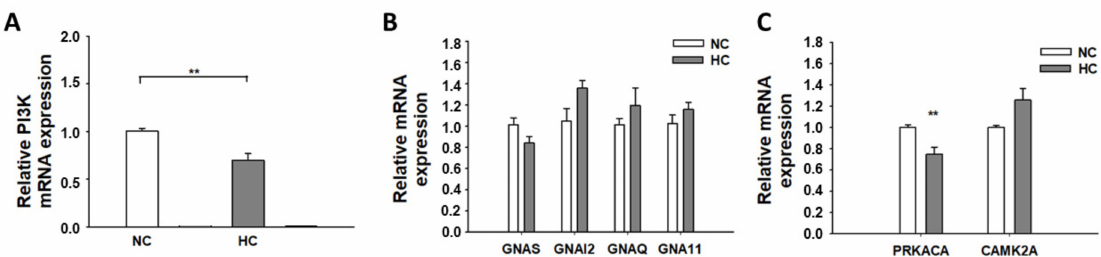
Figure 6. qPCR assay of PI3K, G protein, PKA, and CaMKII expression in hiPSC-CMs cultured with a high level of glucose. ( A ) The expression level of mRNA for PI3-kinase (PI3K) in hiPSC-CMs with normal (NC) and high glucose (HC). ( B )The expression level of Gs (GNAS), Gi (GNAI2), Gq (GNAQ and GNA11) in hiPSC-CMs with normal (NC) and high glucose (HC). ( C ) The expression level of PKA (PRKACA) and CaMKII (CAMK2A) in hiPSC-CMs treated with normal (NC) and high concentration (HC) of glucose. Data are presented as mean ± SEM and analyzed by t -test. (n = 3, biological replicates). ** p < 0.01.